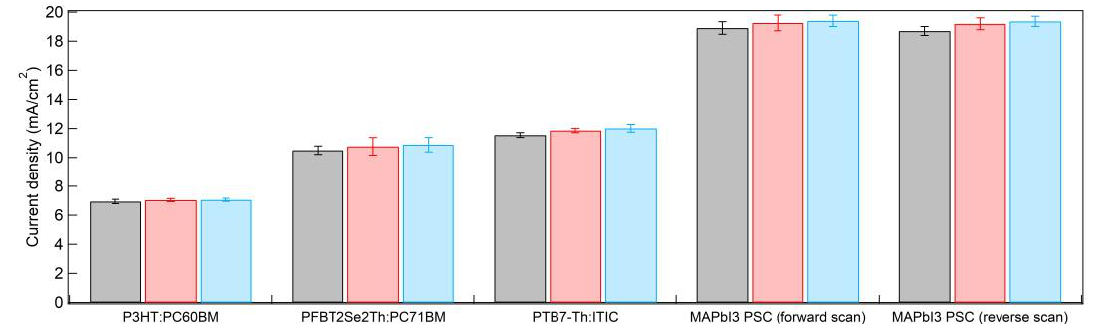
Figure 14. The average J sc barcharts with error bars for P3HT:PC 61 BM OSCs, PFBT2Se2Th:PC 71 BM OSCs, PTB7-Th:ITIC OSCs, and MAPbI 3 PSCs under forward and reverse scans for CCO (black color), 5% Mg:CCO (red color), and 10% Mg:CCO (blue color) HTLs.